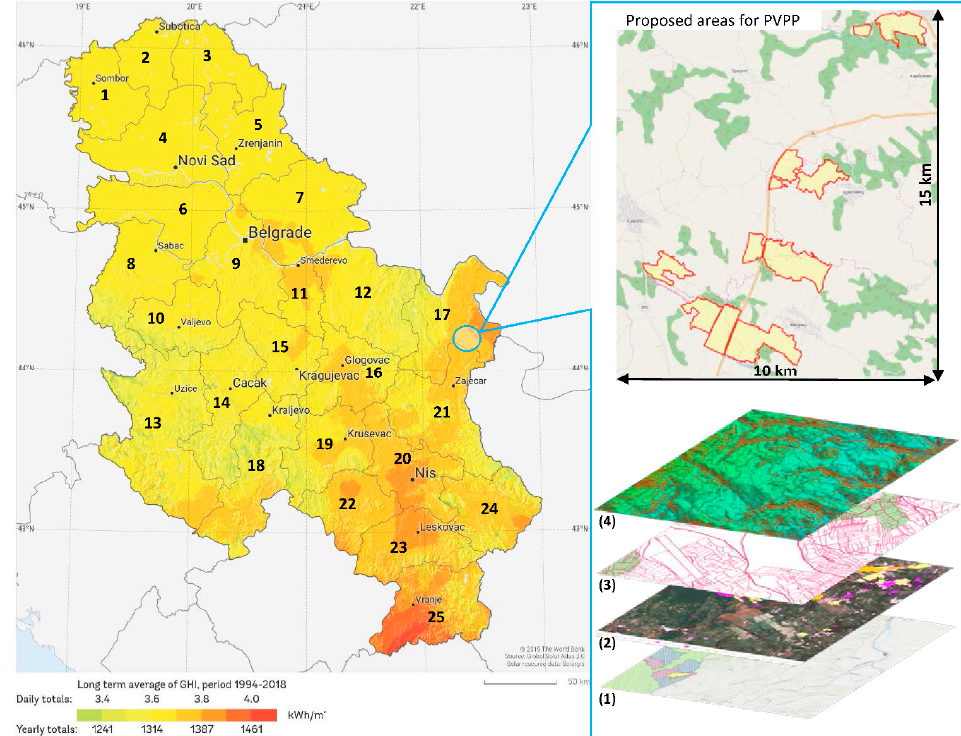
Figure 4. The map of global horizontal irradiation [89] in the Republic of Serbia with the illustration of PV energy potential estimation for a single targeted region. The numbers 1–25 denote the administrative districts in Serbia. Layers: (1) Nature protected areas, (2) Soil quality, (2) Urbanism and infrastructure, (4) Topography.